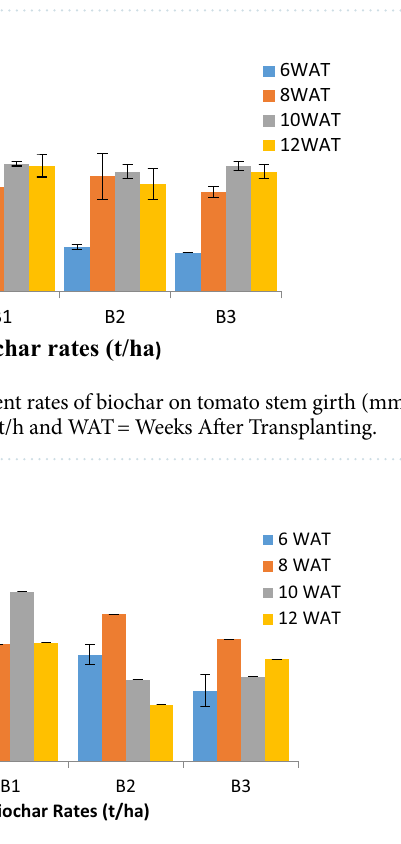
Figure 3. Impact of different rates of biochar on the height (cm 2 ) of tomato plant at different weeks of planting. B1 = 2.5 t/ha, B2 = 5.0 t/ha, B3 = 7.5 t/ha and WAT = Weeks After Transplanting.